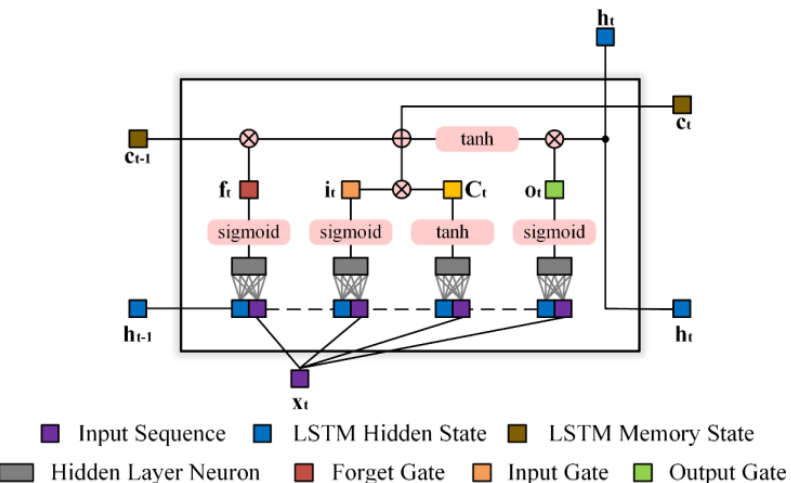
Figure 8. Internal network structure of the LSTM cell.